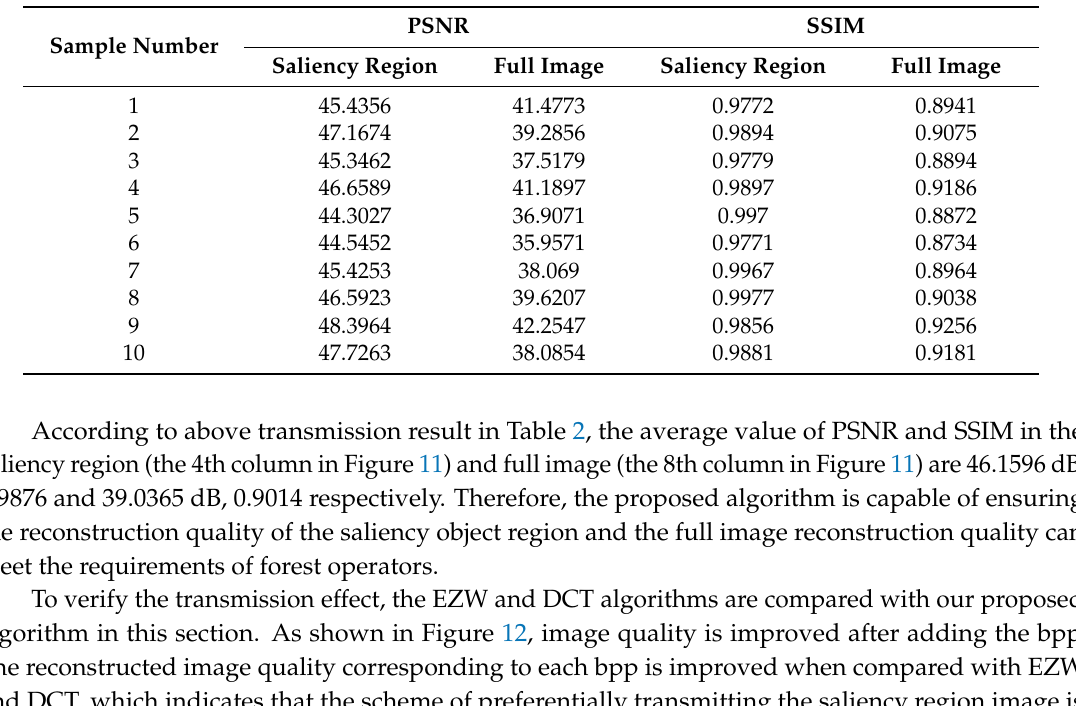
Table 3. Mean time comparison of transmission.